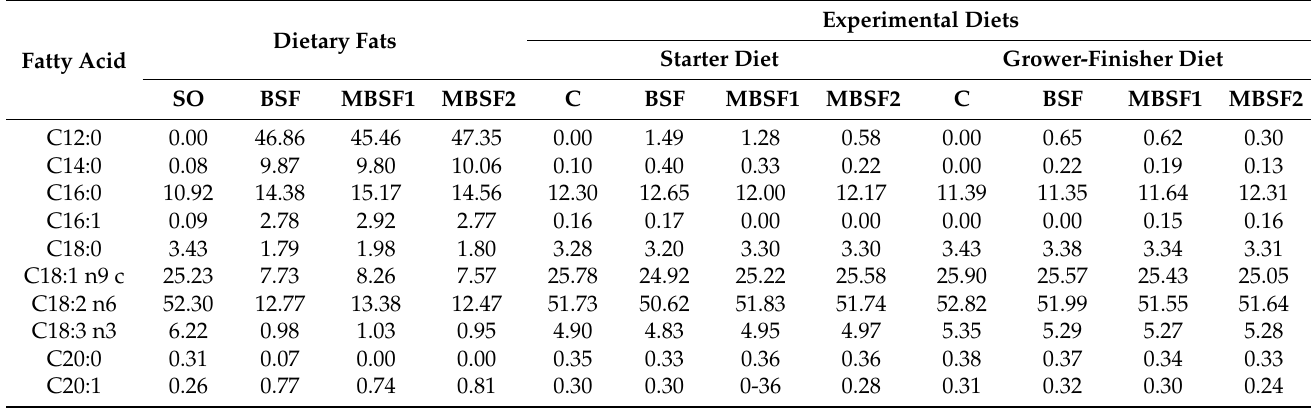
Table 2. Fatty acid profile of dietary fats and experimental diets (% of total